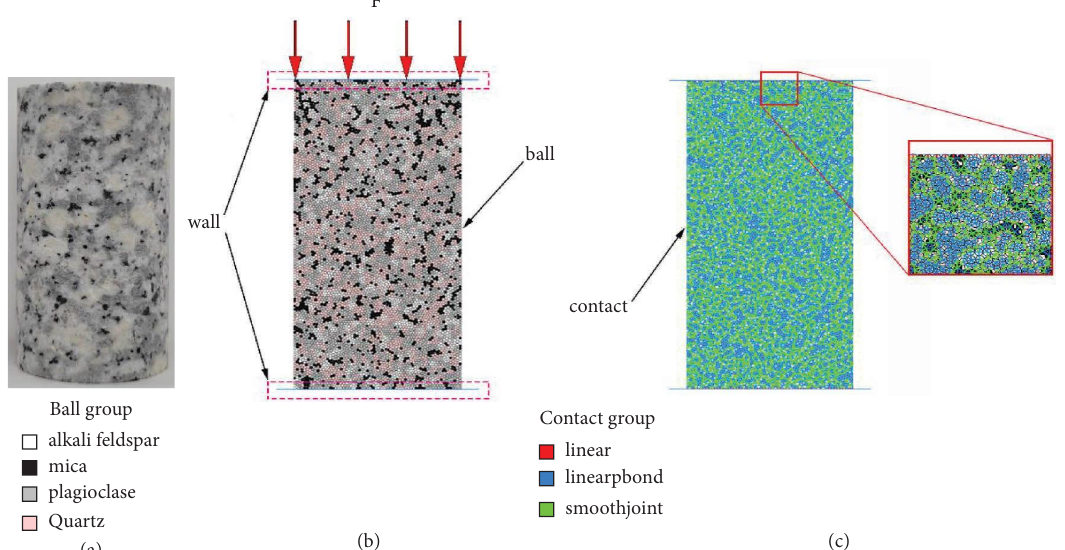
Figure 2: Granite sample and numerical simulation model: (a) granite specimens, (b) granite heterogeneous model, and (c) granite contact force